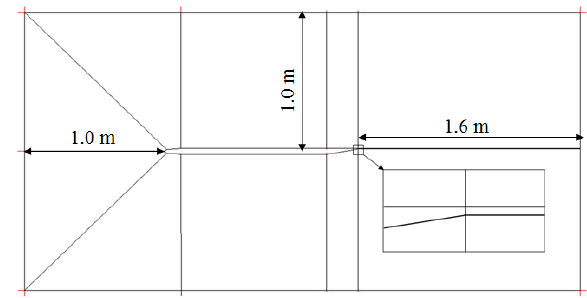
Fig. 8. Flat plate test case